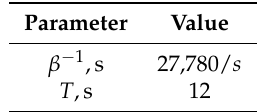
Table 1. Parameters of the example.